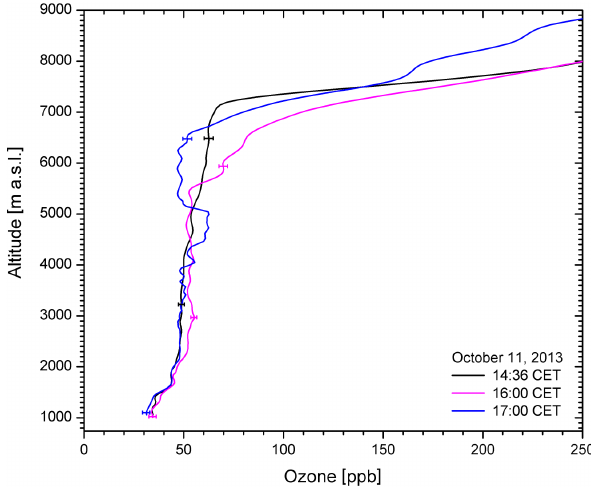
Fig. 18. The ozone measurements on October 11, 2013, show a layer with just slightly enhanced Figure 18. The ozone measurements on 11 October 2013 show ozone gradually separating from the tropopause (located at about 7 km a.s.l.), centred at about 6 km a layer with slightly enhanced ozone gradually separating from the at 16:00 CET and at 4.75 km at 17:00 CET. Please, note the small error bars after recent system upgrading. tropopause (located at about 7kma . s . l . ), centred at about 6km at 16:00CET and at 4.75km at 17:00CET. Note the small error bars after recent system